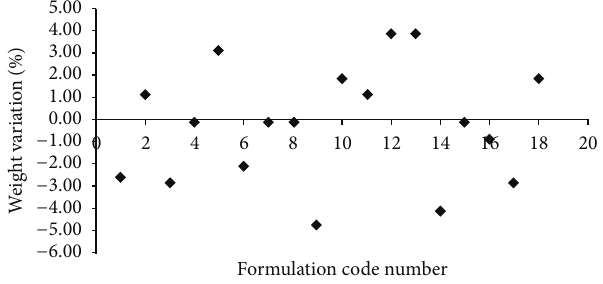
Figure 3: Weight variation analysis of OS of DSL ( 𝑛 = 10 ).